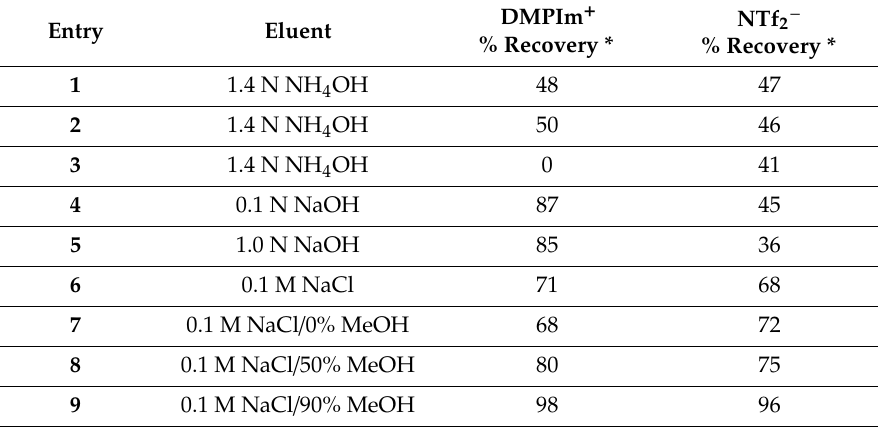
Table 2. Experimental extraction recoveries of [DMPIm][NTf 2